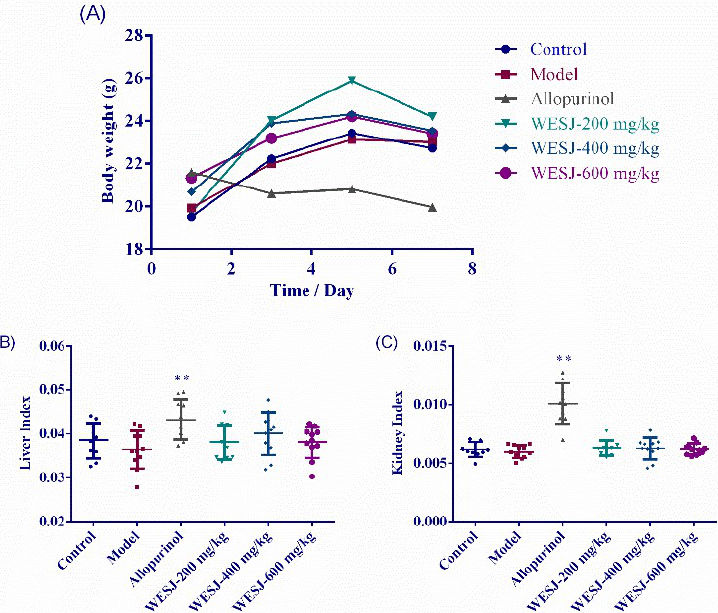
Figure 3. Effects of WESJ on body weight and organ index in hyperuricemic mice. ( A ) Body weight in different groups; ( B ) liver index in different groups; ( C ) kidney index in different groups. Data were expressed as mean ± S.E.M. ( n = 10). ** p < 0.01, compared with model group.